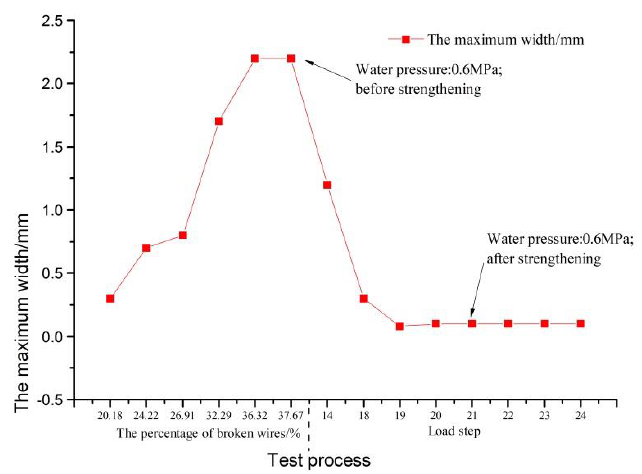
Figure 17. The change of maximum width of cracks in the outer concrete core.